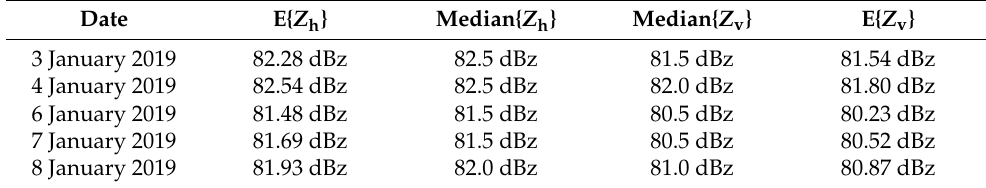
Table 6. Same as Table 5, but for January 2019.